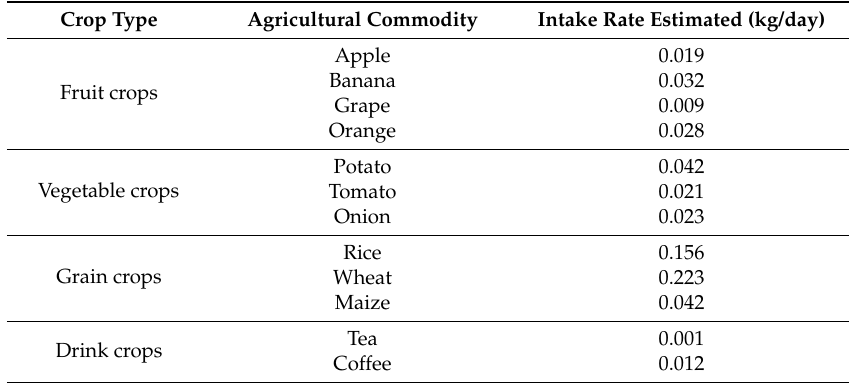
Table 3. Estimated intake rates for the most consumed agricultural